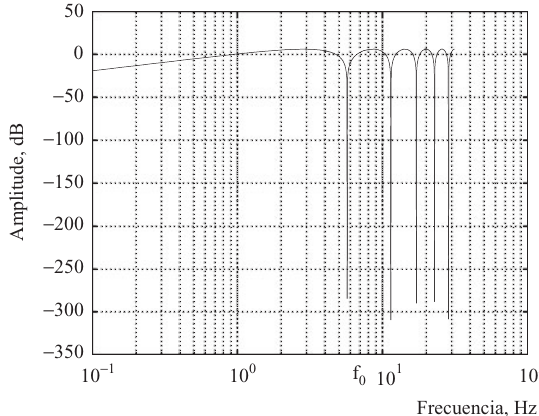
Figure 5 An active notch filter is implemented by means of the active orthosis. In this scheme, the notch filter frequency, ω 0 , lies exactly at the tremor